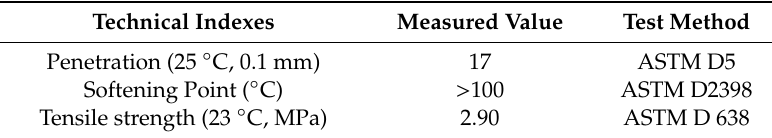
Table 2. Performance parameters of epoxy